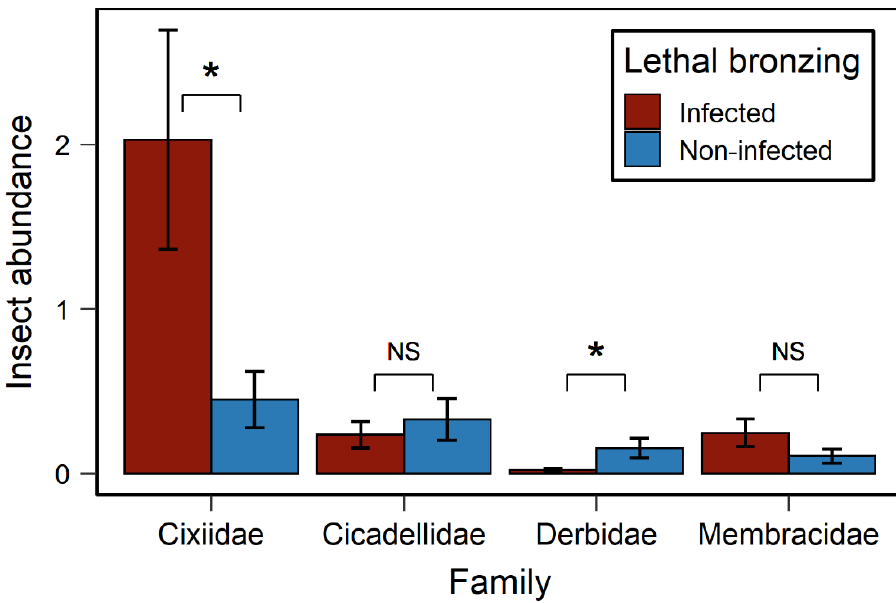
Figure 2. Insect abundance on lethal bronzing-infected and non-infected palms. Values are estimated marginal means ± SE of each family on each trap each week. Asterisks (*) represent significant difference ( p < 0.05) between LB-infected and non-infected palms under ANOVA of GLMM model.